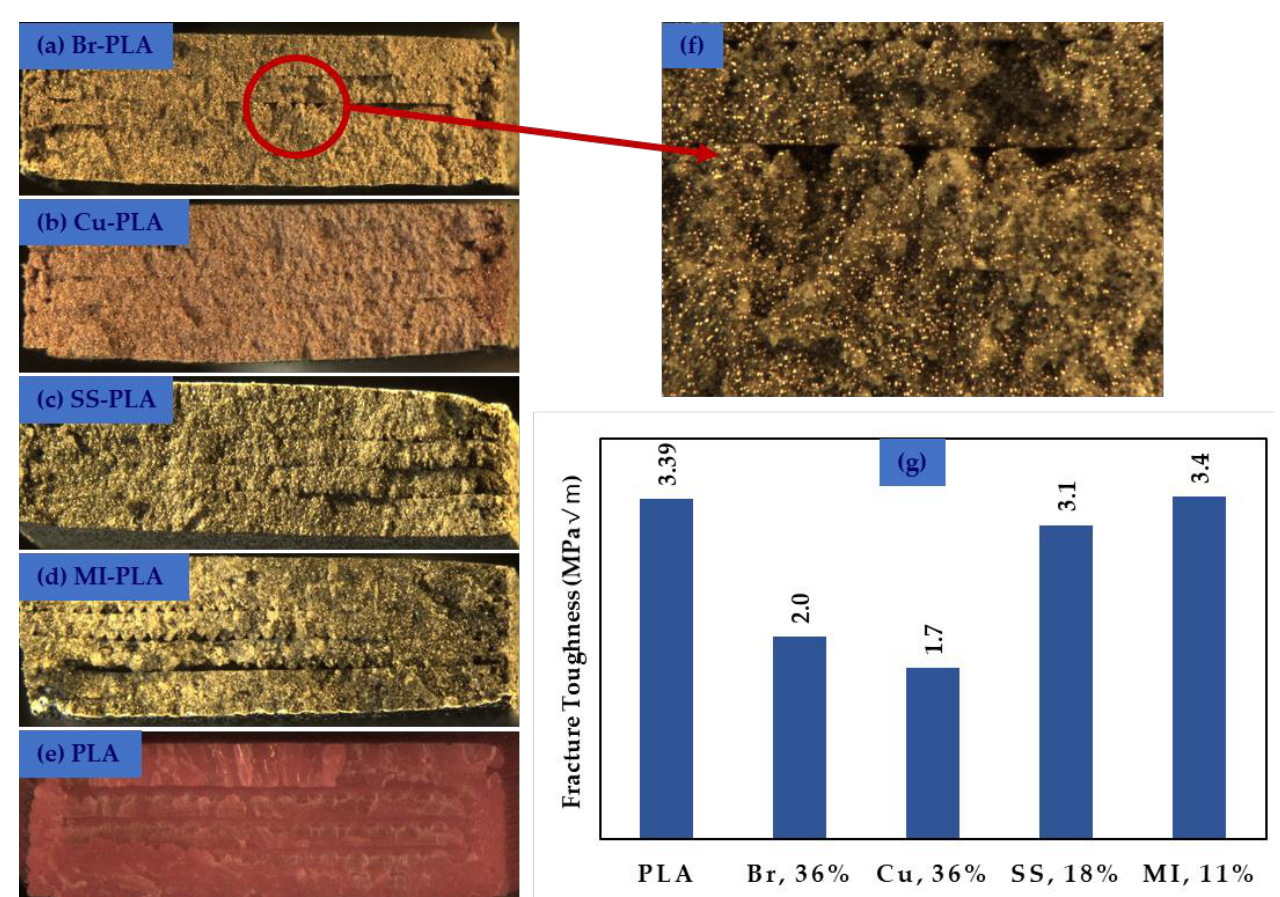
Figure 12. Data obtained from a three-point flexural test on Br-PLA.